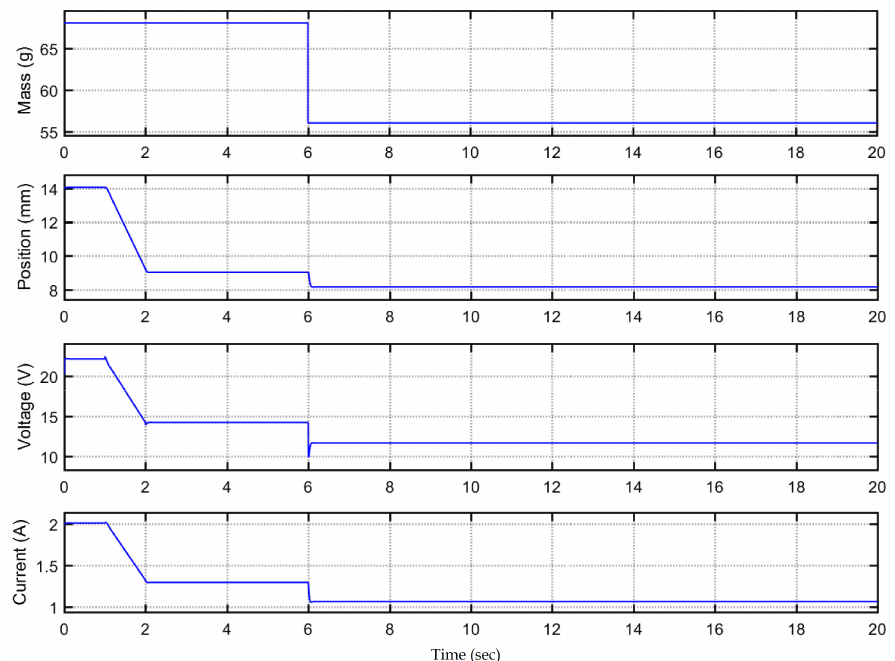
Figure 6. Response of coil voltage, coil current with sudden increment of 15% in mass of steel ball.